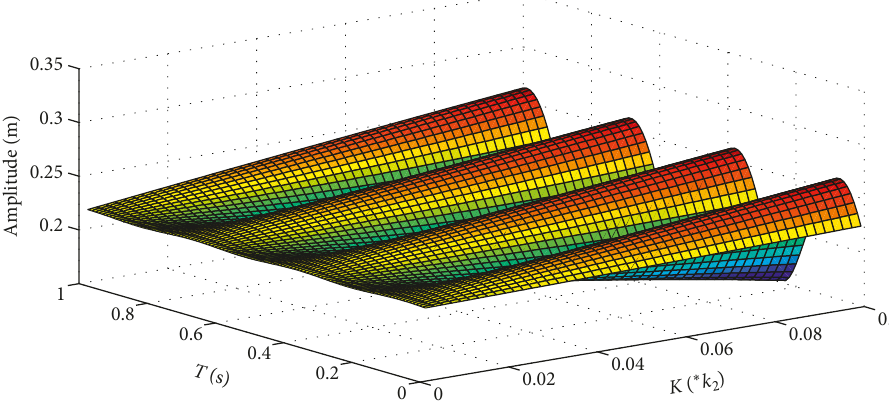
Figure 9: Variation of galloping amplitude of m 1 with time-delay parameter T and strength parameter K .